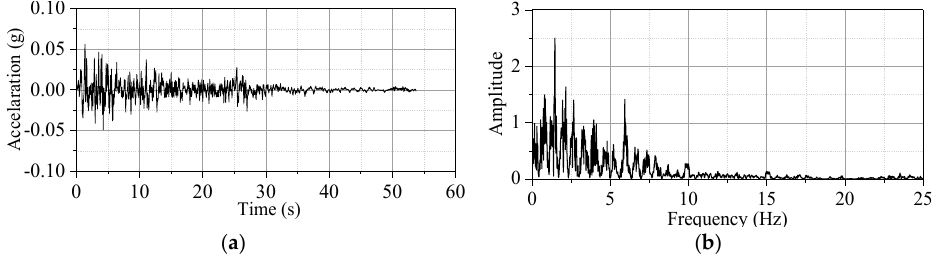
Figure 6. Input bedrock ground motion: ( a ) acceleration time history; ( b ) Fourier spectrum.